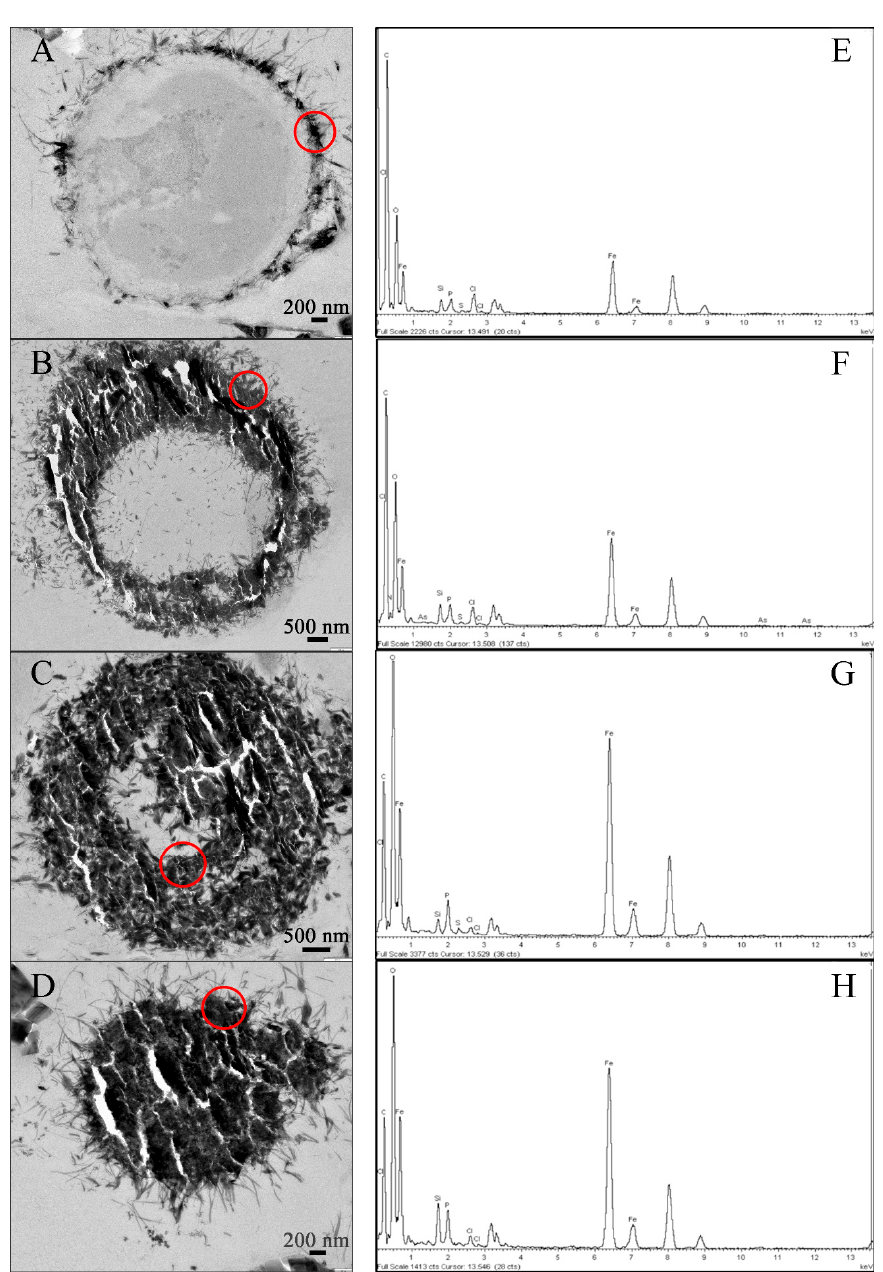
Figure 4. TEM and EDX analyses of the evolution of fungal mineralized structures from the M13 deposits. ( A ) Mineralization starts on the outer-side of the fungal cell wall, scale bar 200 nm; ( B ) and ( C ) intermediate states of mineralization, scale bars 500 nm; ( D ) mineral completely covering the fungal cell, scale bar 200 nm. Circles indicate the areas where the EDX analyses were obtained; ( E ) Figure 4A EDX spectrum; ( F ) Figure 4B EDX spectrum; ( G ) Figure 4C EDX spectrum; ( H ) Figure 4D EDX spectrum.